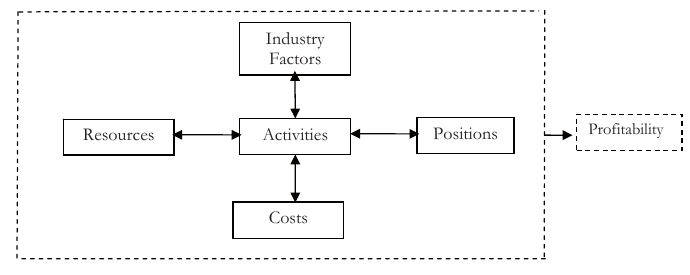
Fig. 1 - Components of business model by A. Afuah